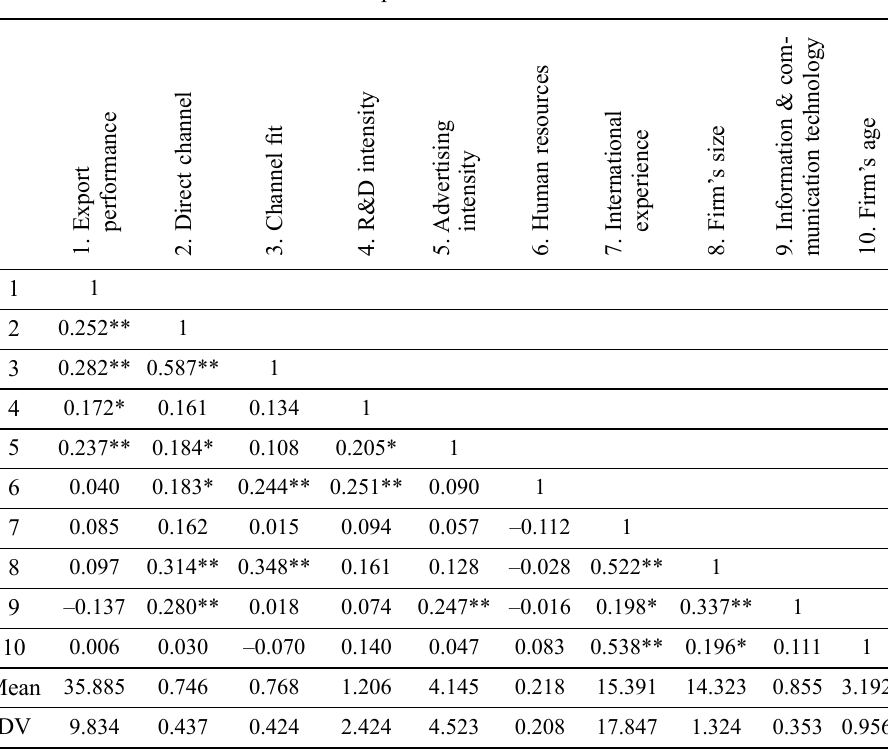
Table 2. Spearman’s